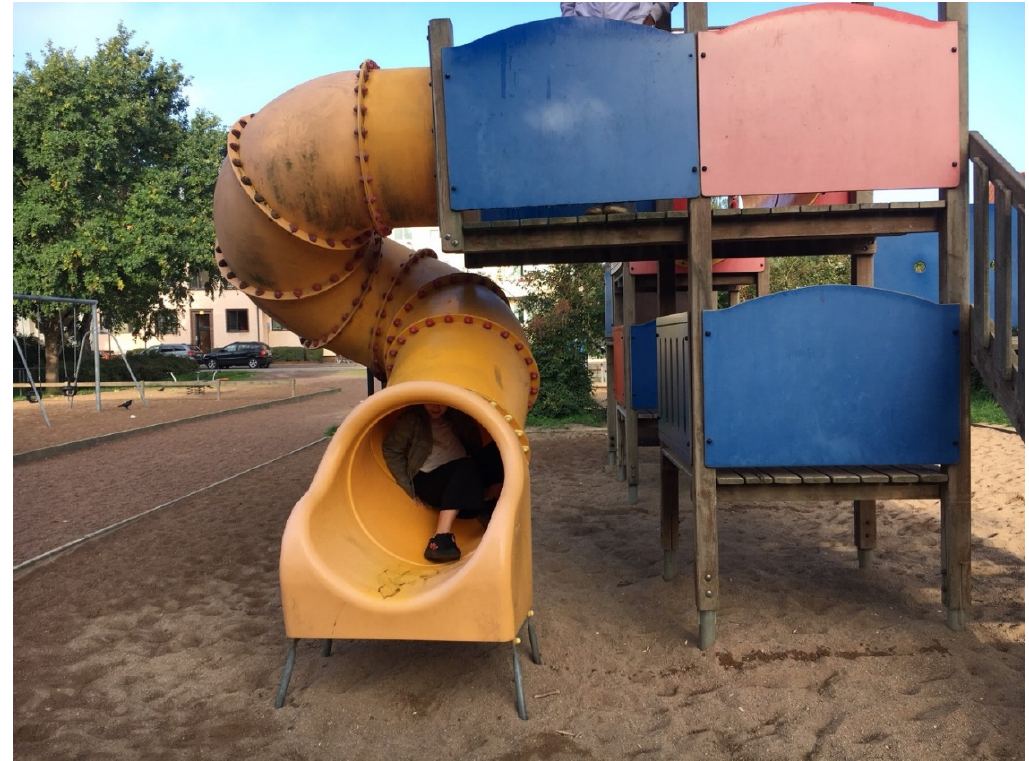
Figure 3. The slide and other equipment were popular among the children, as places to be